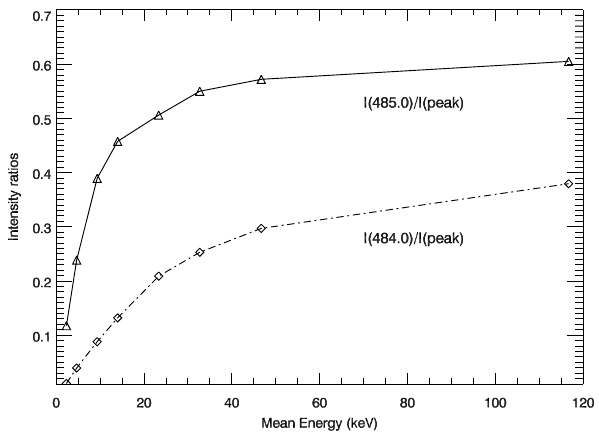
Fig. 4. Ratios of spectral brightness of the blue-shifted wing at 484nm and 485nm to that of the peak for convolved synthetic H- β line profiles and its variation with the mean energy of the precipi- tating